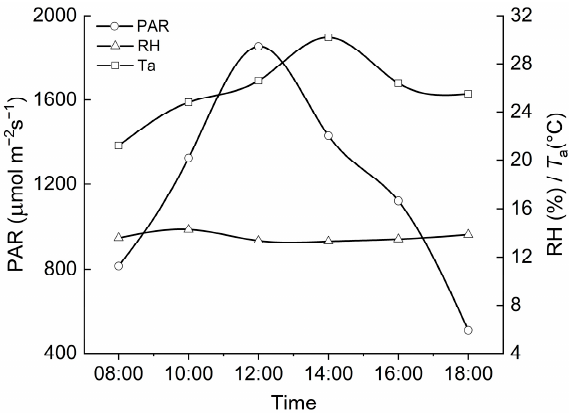
Figure 1. Diurnal changes of photosynthetically active radiation (PAR), air relative humidity (RH), and air temperature ( T a ) during the measurement period (20–22 July 2019).